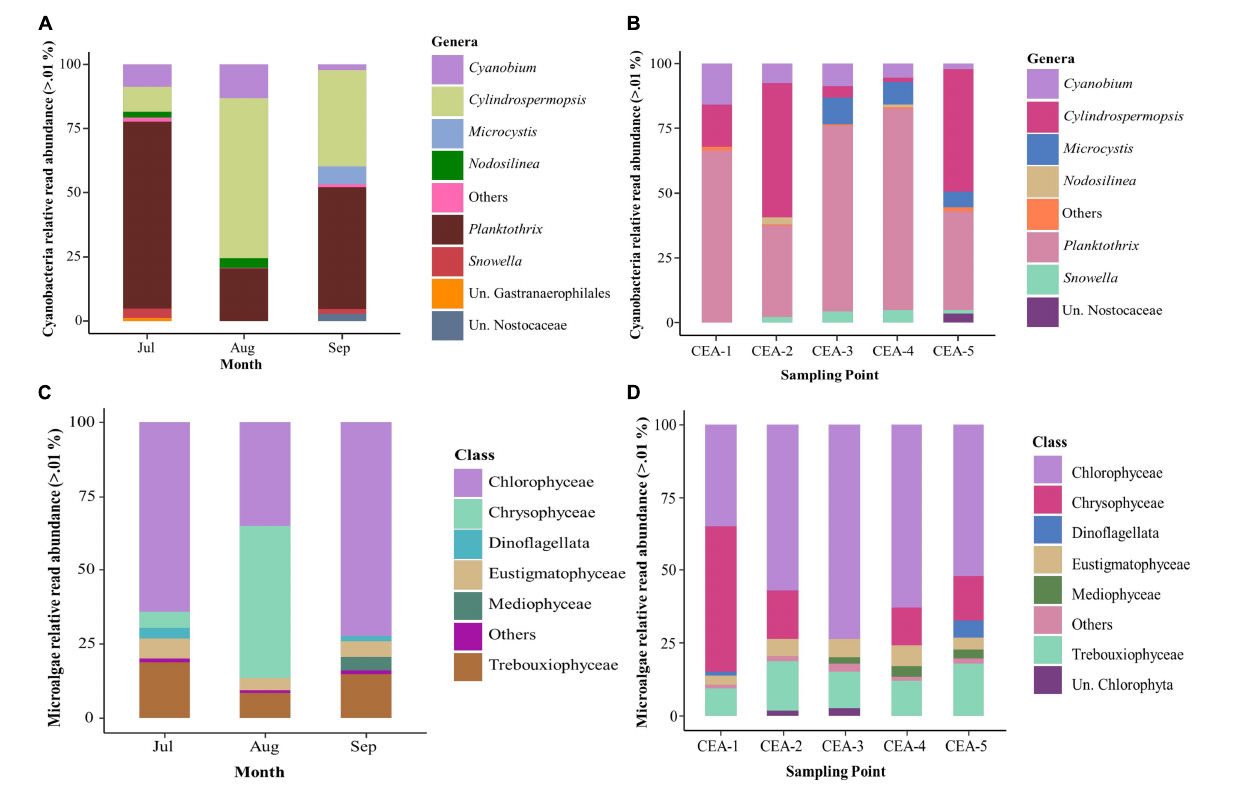
FIGURE 6 | Relative read abundance of cyanobacterial and microalgae communities by month and sampling point. (A) Cyanobacteria genera relative read abundance by sampling month. (B) Cyanobacteria genera relative read abundance by sampling point. (C) Microalgae classes relative read abundance by sampling month. (D) Microalgae classes relative read abundance by sampling